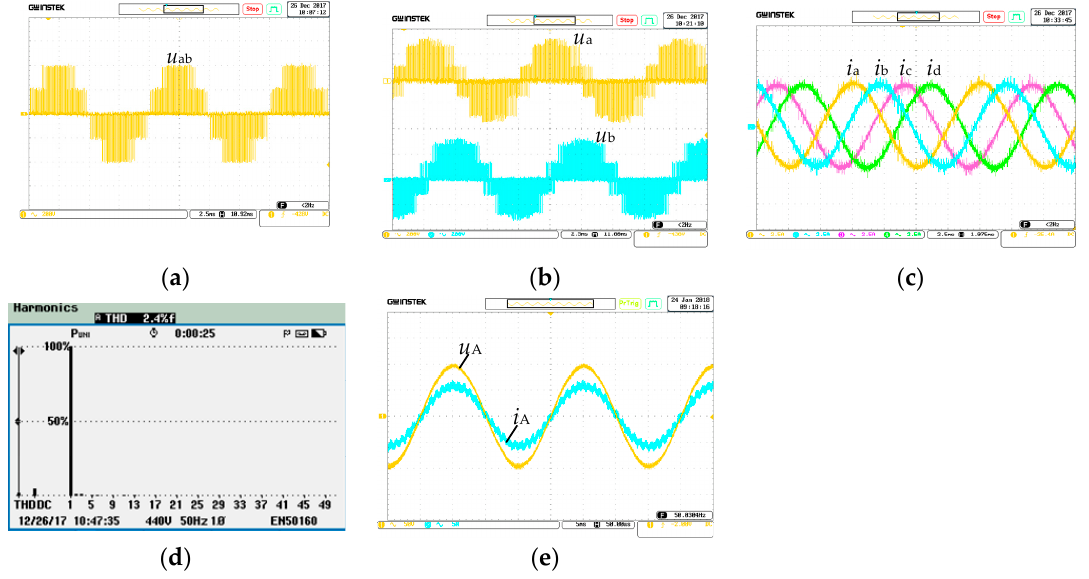
Figure 12. Experimental waveforms under the output parameter 100 V/100 Hz ( a ) output line-to-line voltage ( u ab ); ( b ) output phase voltage ( u a , u b ); ( c ) output currents ( i a , i b , i c , i d ); ( d ) the Fast Fourier Transformation (FFT) analysis of i a ; ( e ) input phase voltage and current ( u A , i A ).